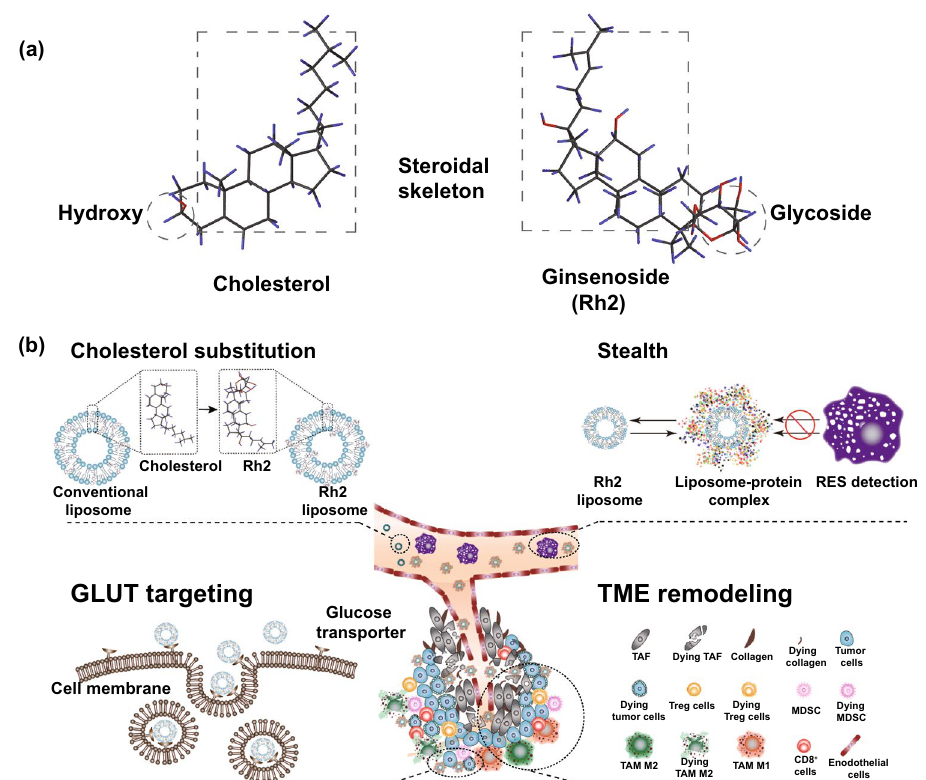
Fig. 1 Rational design of a multifunctional Rh2-lipo for tumor targeting therapy. a Chemical structure of cholesterol and ginsenoside. b In Rh2- lipo, cholesterol was substituted by Rh2, which works as membrane stabilizer, long-circulating stealther, targeting ligand of GLUT and chemo- therapy adjuvant at the same time, empowering liposome with multiple functions including long circulation, active targeting, TME remodeling, and tumor cell killing